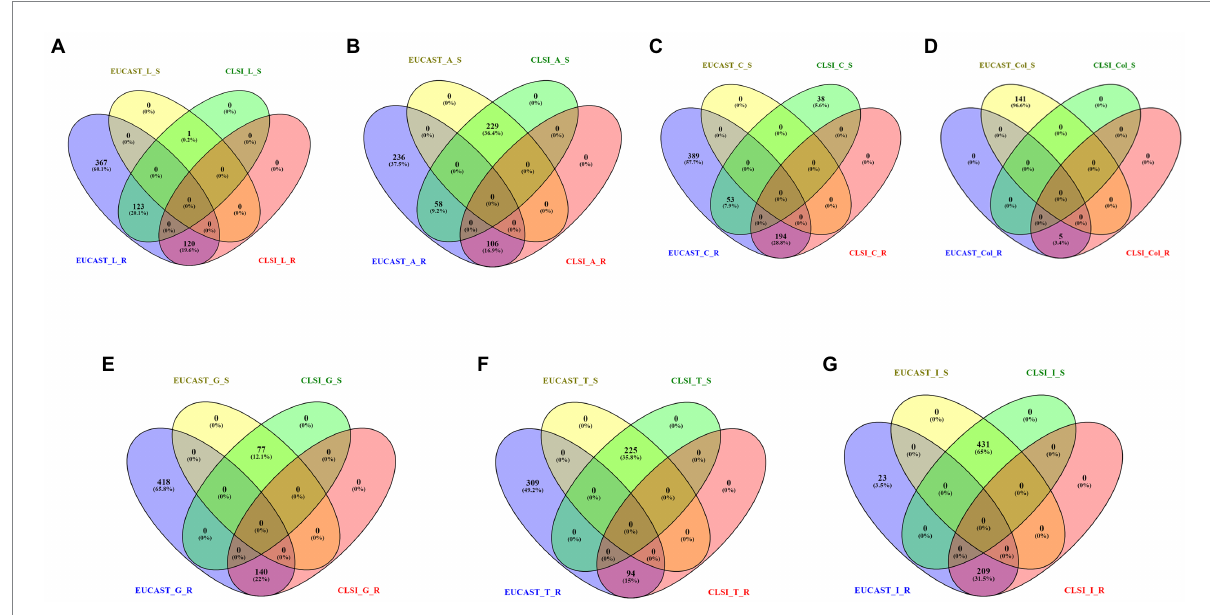
FIGURE 4 Resistant (R) and susceptible (S) classification by CLSI/EUCAST for the following antibiotics: (A) levofloxacin, (B) amikacin, (C) ciprofloxacin, (D) colistin, (E) gentamicin, (F) tobramycin, and (G)